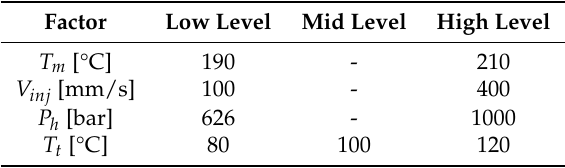
Table 3. X-ray CT was used for part measurements and analysis, which is explained in the next